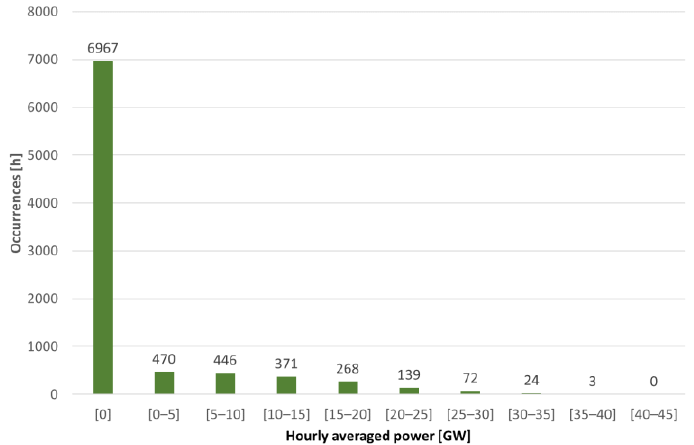
Figure 16. Distribution of hourly averaged power over the year of surplus users in Case 2.